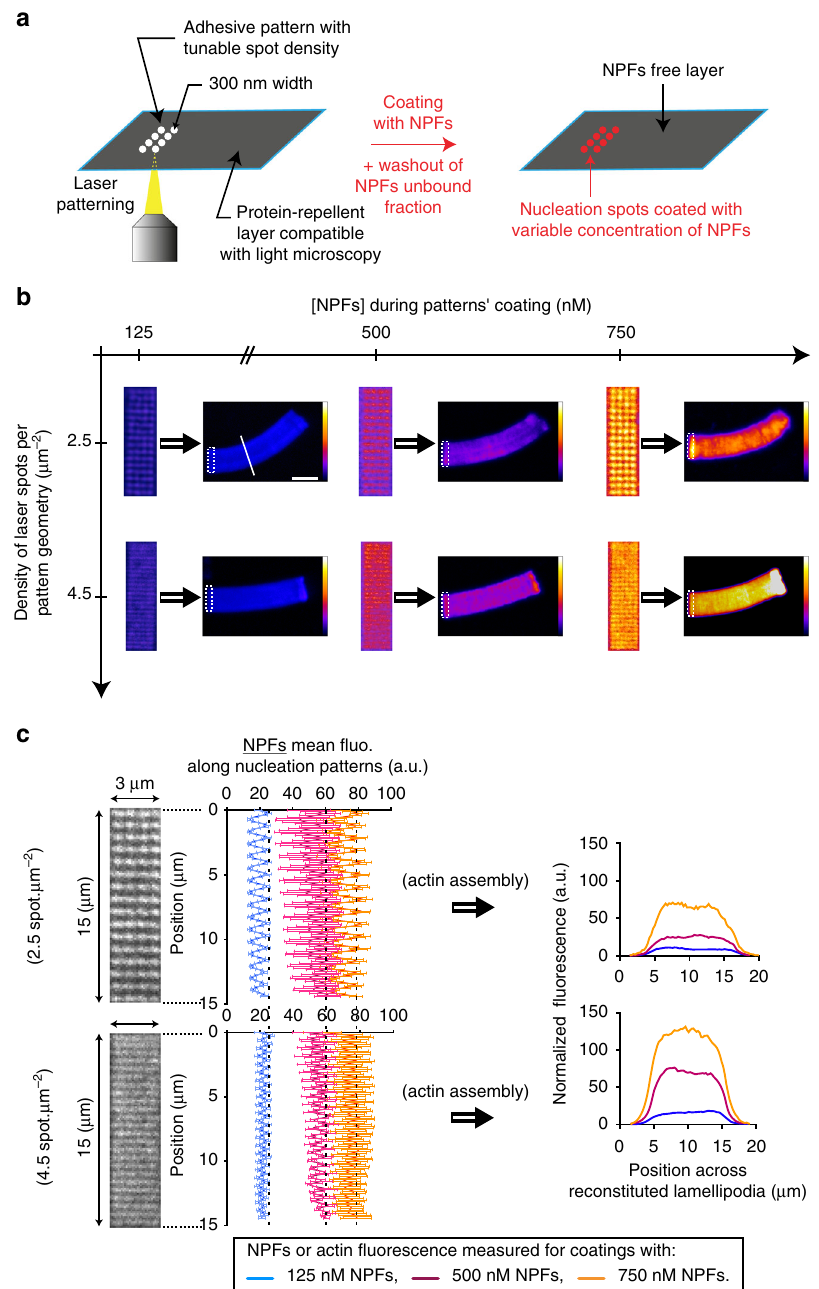
Fig. 3 Laser-patterning method allows for the precise control of the density and the geometrical organization of actin fi laments in growing actin network. a Adhesive spots of 300nm in diameter were printed on silane-PEG-coated coverslip with 355nm pulsed laser. Adhesive patterns consisted of arrays of spots of controllable density, and were speci fi cally coated with a de fi ned amount of NPFs. b Two independent parameters, spot density of the nucleation pattern and NPF concentration used for pattern coating, controlled actin fi lament density and geometrical organization within LMs. Dynamic LMs were reconstituted with the standard puri fi ed medium. For each image, dotted rectangles indicate the position of the nucleation pattern, and the LUT scale measures the actin-network fl uorescence. c Quantitative analysis of NPF density coated on the nucleation patterns. For each coating condition, the NPF fl uorescence on 3×15 µ m 2 patterns was measured and the mean fl uorescence extracted. After actin assembly on patterns, actin fl uorescence was measured across LMs (along the white line as indicated in panel b , top left image). Error bars represent standard deviation (see also related Supplementary Fig. 7). Scale bar is 15 µ